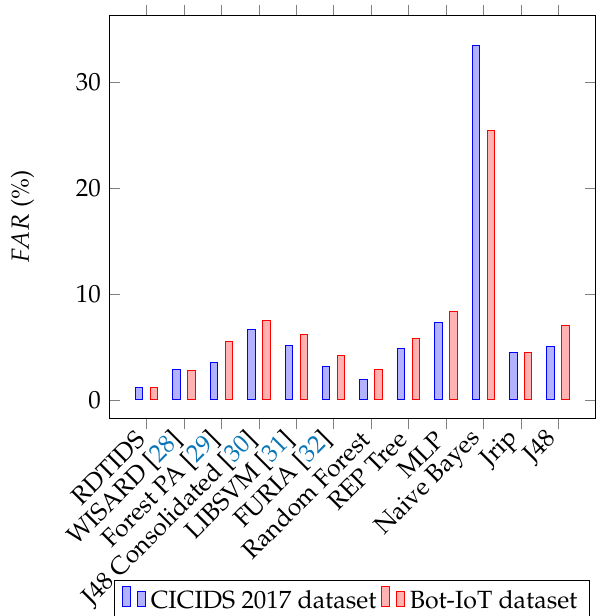
Figure 3. Overall Performance of RDTIDS and other classifiers in terms of false alarm rate.